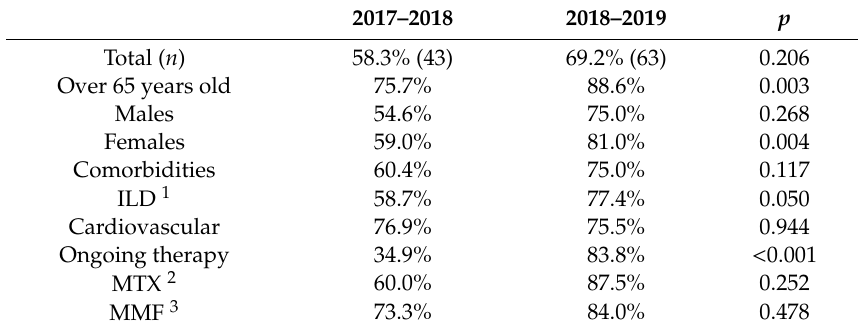
Table 2. Changes in flu vaccination coverage between the 2017–2018 and 2018–2019 seasons.